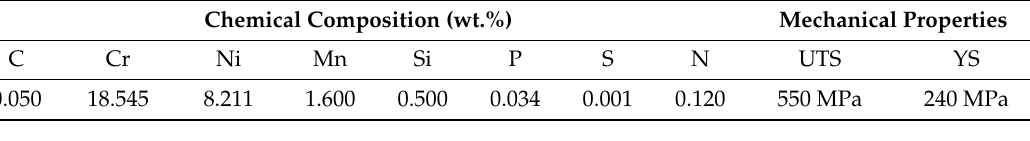
Table 1. Chemical composition and mechanical properties of AISI 304N austenitic stainless steel. Chemical Composition (wt.%)